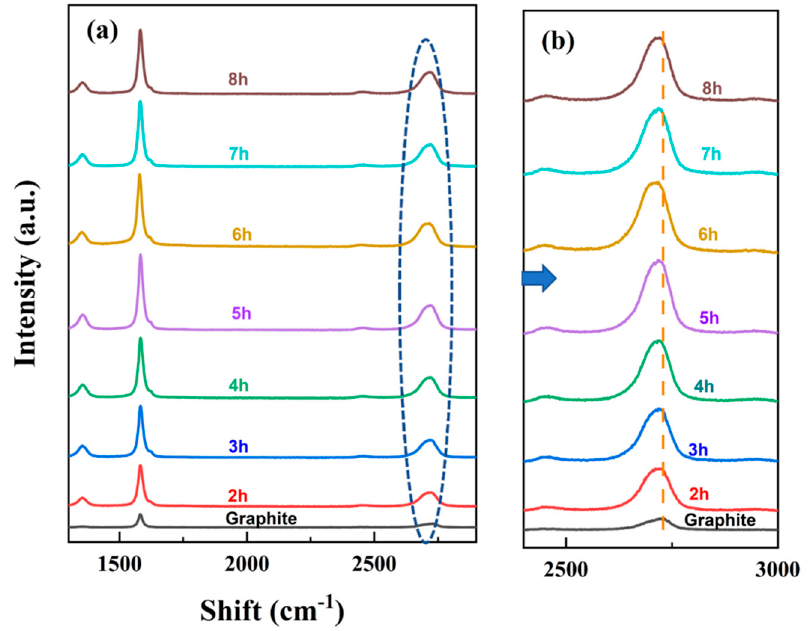
Figure 8. ( a ) Raman spectra of the prepared FFG at different exfoliation time; ( b ) magnified 2D bands of the spectra. Table 2. Effect of exfoliation time on FFG quality indicators determined from Raman spectroscopy. Exfoliation Time